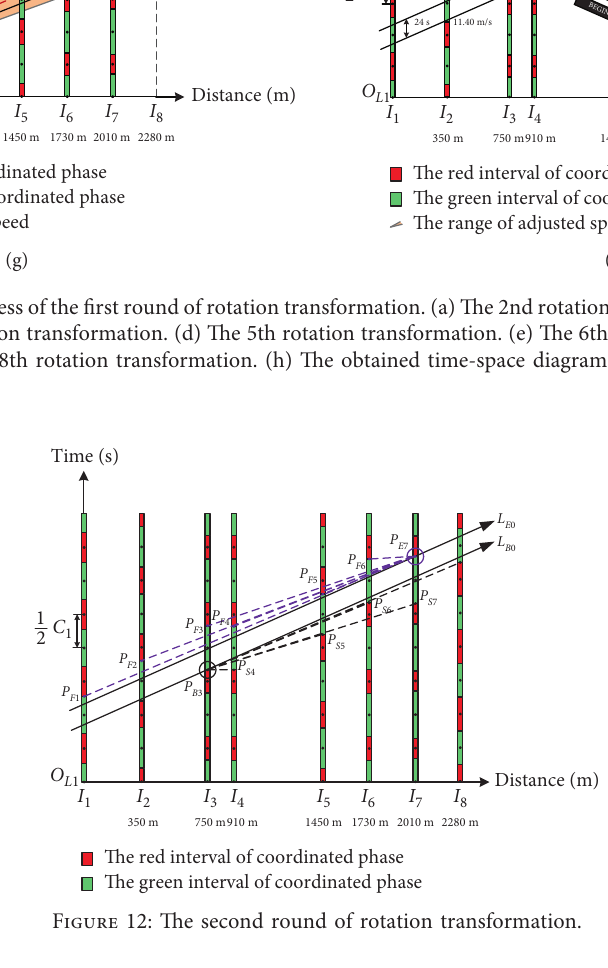
Figure 12: The second round of rotation